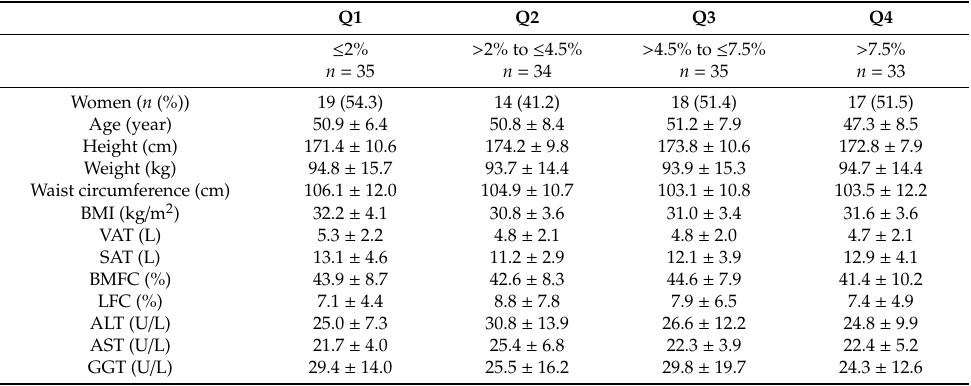
Table 1. Characteristics of the four weight-loss groups (quartile (Q)1 to Q4) at baseline (T0), n = 137. Q1 Q2 Q3 Q4 ≤ 2% > 2% to ≤